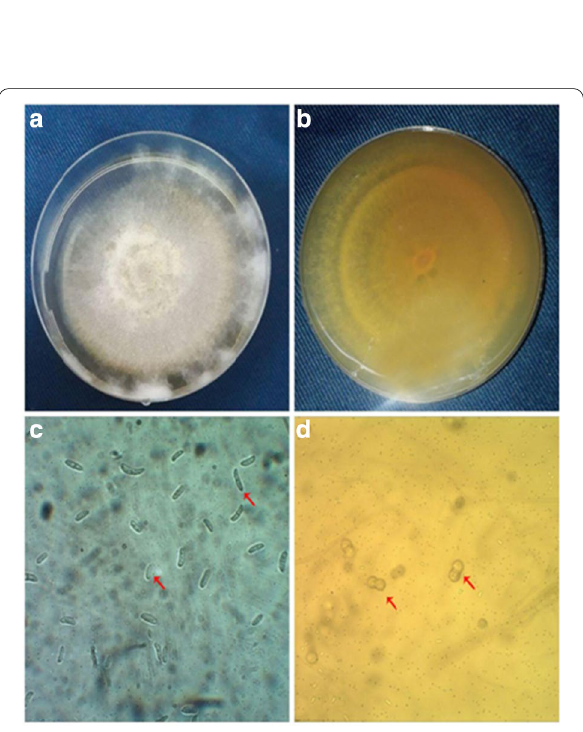
Fig. 7 a F. solani on PDA (TOP), b F. solani on PDA (bottom), c macroconidia and macroconidia, d